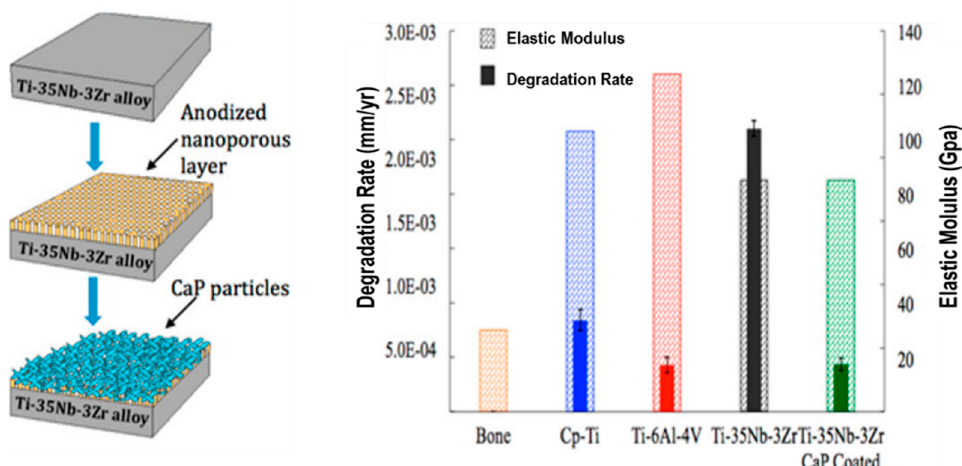
Figure 15. Comparing the degradation rate and elastic modulus of the conventional implant materials to the β -Ti-35Nb-3Zr alloy. Reprinted with permission from [163], copyright (2017) American Chemical Society.